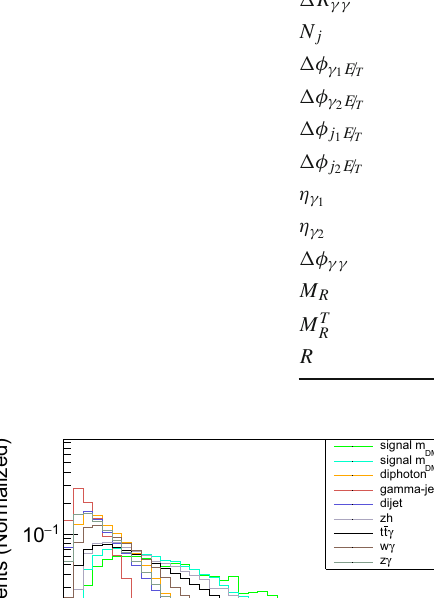
Table 7 Feature variables for training in the ML analysis for the γγ + / E T channel. The observables which were used in the cut-based analysis have been separated from the new ones by a horizontal line